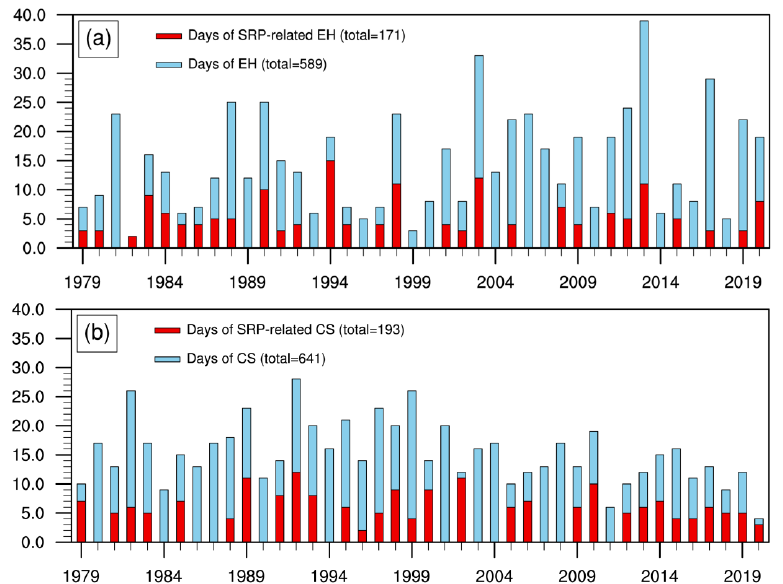
Figure 9. Days of heat wave cases (( a ), light blue rectangle; red rectangles represent the days of heat wave cases related to SRP+) and cool summer processes (( b ), blue rectangle; red rectangles represent the days of cool summer cases related to SRP−) within the YRV (114–122° E, 27–32° N) in each summer (June–August) during 1979–2020.